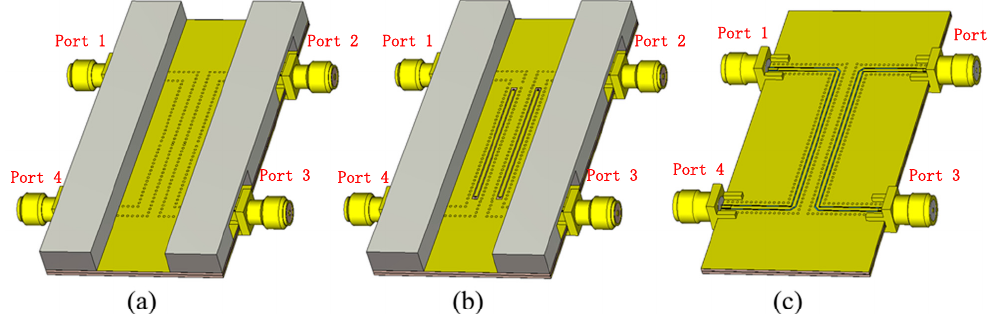
Figure 1. The 3D models of the SICL-TS (Substrate Integrated Coaxial Line- Test Set) ( a ), GCPW-TS (Grounded CoPlanar Waveguide-Test Set) ( b ) and GCPW-RS (Grounded CoPlanar Waveguide-Reference Set) ( c ).